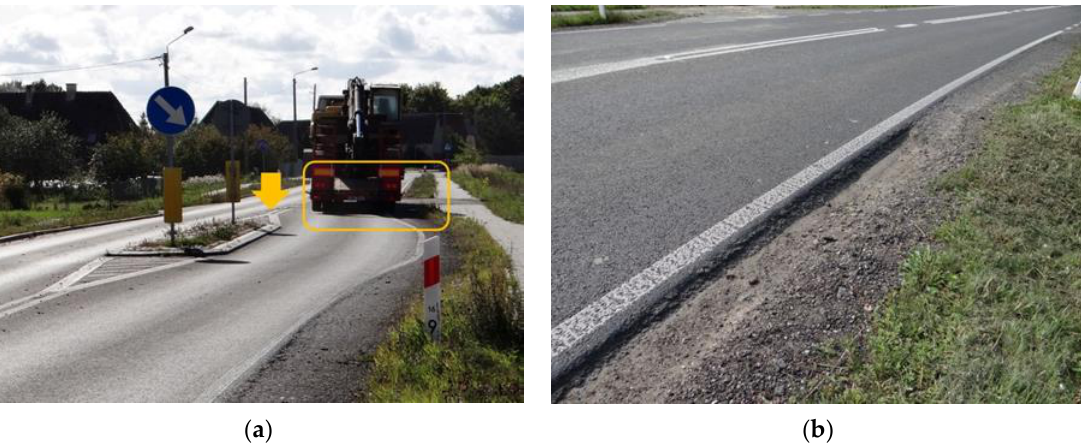
Figure 14. Examples of poor design of horizontal deflection treatments related to the road surface construction: ( a ) Agri- cultural machine overrunning the shoulder surfaced with milled asphalt after passing the central island; ( b ) resulting road shoulder deterioration. Source: own work of the authors.